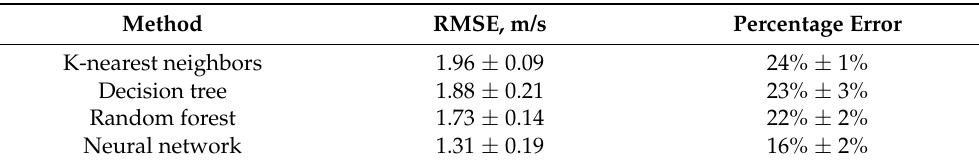
Table 3. Comparison of different machine learning methods used for AoPWV estimation. For each case, we present the mean values and standard deviations for seven